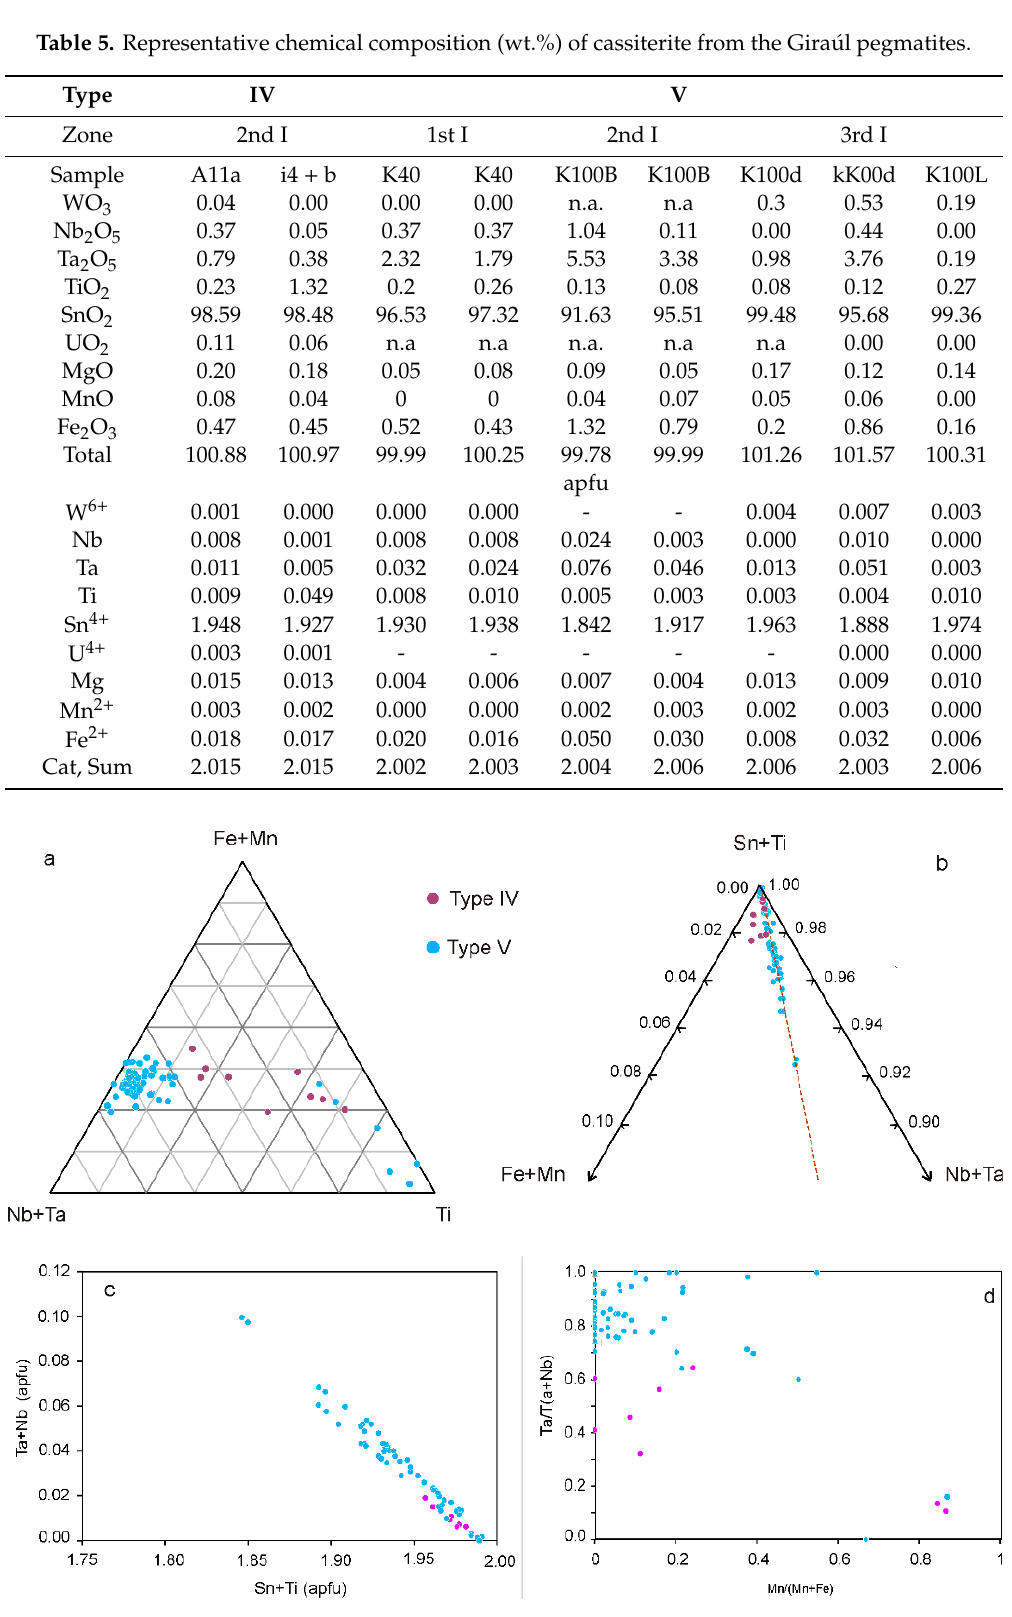
Figure 22. Cassiterite composition from the Giraúl pegmatites. ( a ) Fe + Mn – Nb + Ta − Ti diagram. ( b ) Fe + Mn – Sn + Ti – Nb + Ta diagram. ( c ) Sn + Ti vs Ta + Nb. ( d ) Ta/(Ta + Nb)/(Mn/(Mn + Fe) quadrilateral.